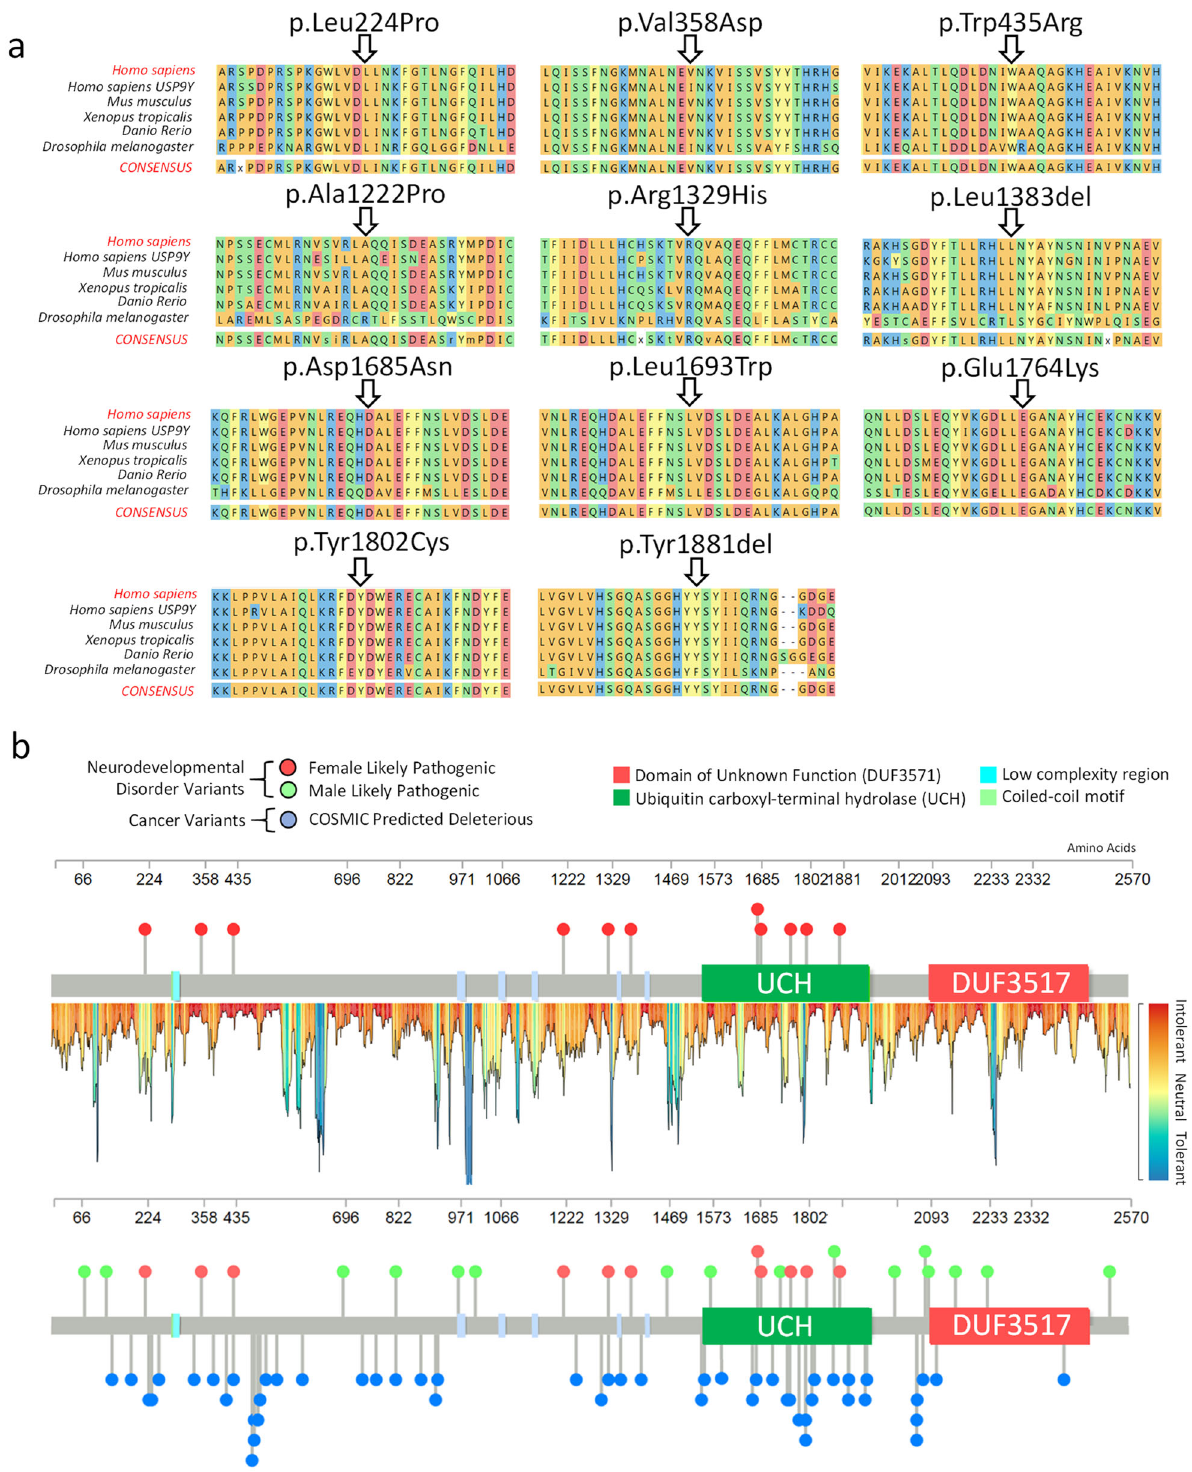
Fig. 1 Conservation and protein location of likely pathogenic USP9X-female variants. a Cross species protein alignment of USP9X showing conservation of altered amino acid residues. b Location of female likely pathogenic variants on the USP9X protein structure. USP9X variation tolerance landscape is provided (see Materials and Methods). Locations of male likely pathogenic variants and predicted deleterious missense somatic cancer variants (extracted from COSMIC database with CADD score ≥ 30) are shown for